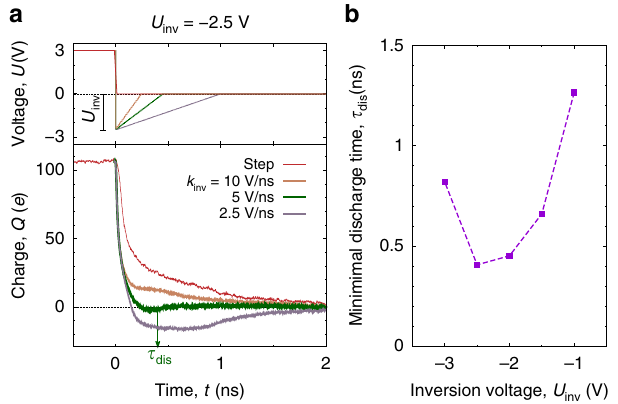
Fig. 6 Accelerating discharging by voltage inversion. a Voltage with respect to the bulk electrolyte as a function of time for step-voltage discharging (red line) and for three voltage-inversion sweeps given by eq. (10) (top plot). Bottom plot shows the charge in the nanopore obtained by MD simulations after application of the inversion sweeps, eq. (10), to a model supercapacitor shown in Fig. 1d. The nanopore was initially fully charged at potential U ch = 3 V with respect to the bulk electrolyte. The inversion voltage is U inv = − 2.5 V and the optimal k inv value is k = 5.5 V/ns. The results are an average of 5 independent simulations. inv b Discharging time as a function of U inv , calculated at optimal k inv values. The resulting optimal ( U inv , k inv ) pair is ( − 2.5 V, 5.5 V/ns) for our